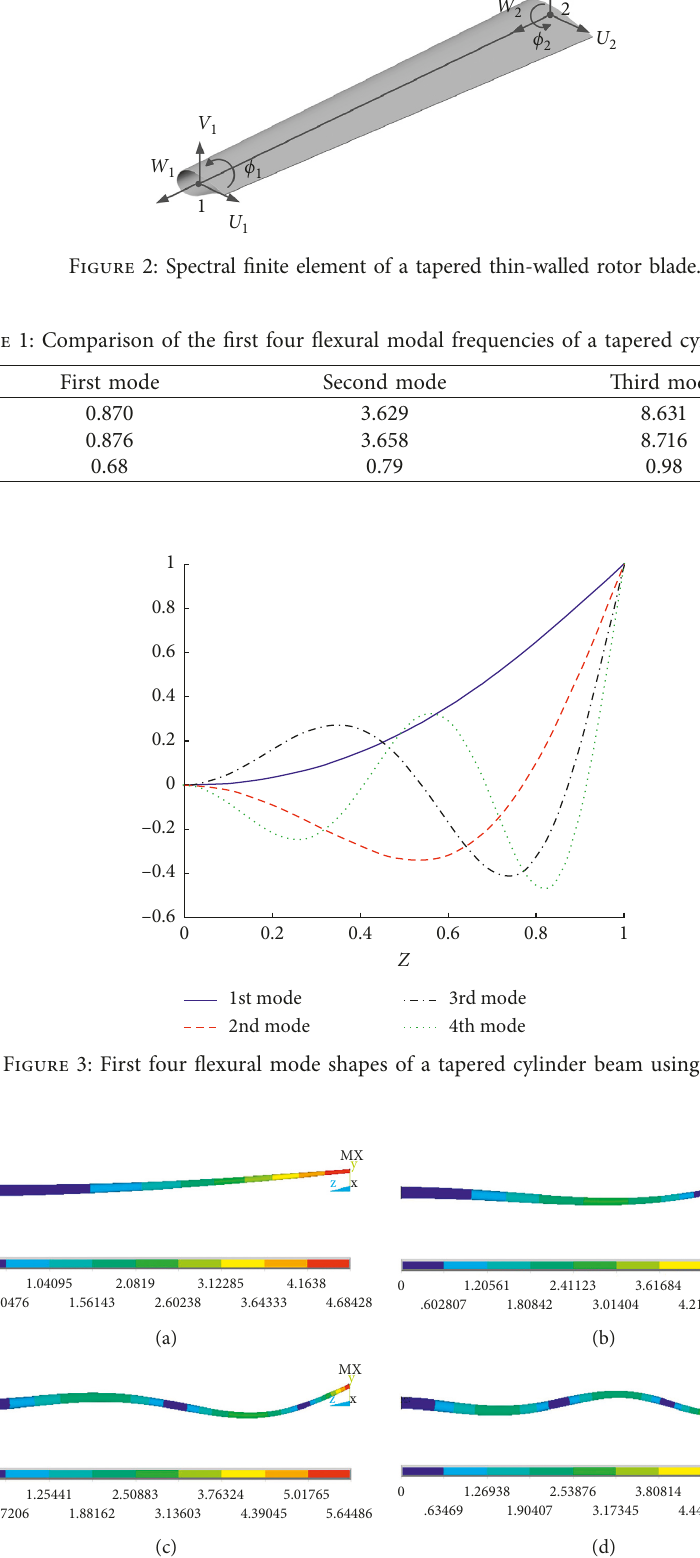
Figure 4: The first four flexural mode shapes of a tapered cylinder beam using ANSYS. (a) First mode shape. (b) Second mode shape. (c) Third mode shape. (d) Fourth mode shape.